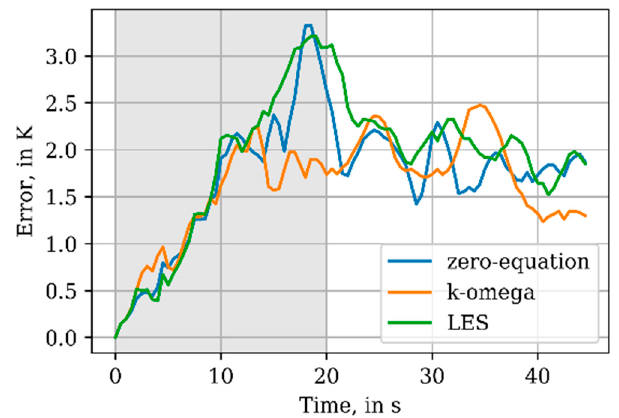
Figure 10. Time series of spatial mean absolute errors.